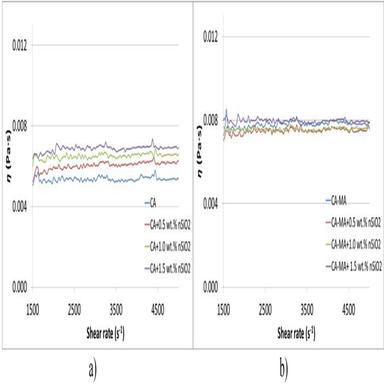
η as function of shear rate of NEPCM: a) based on CA b) based on CA–MA.